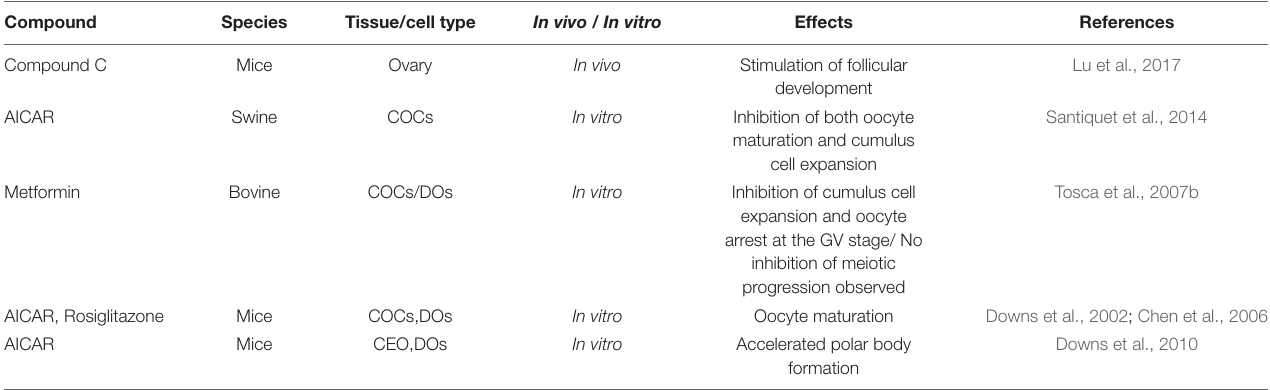
TABLE 1 | Effects of the use of AMPK activator or inhibitor in follicular